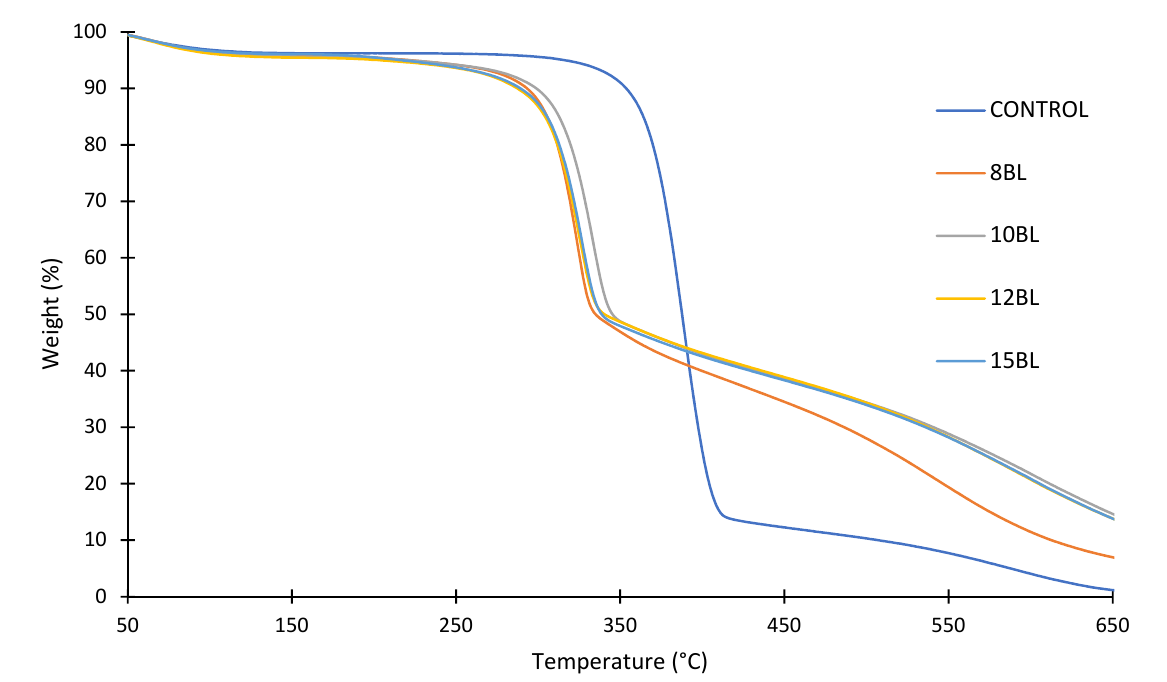
Figure 4. TGA of untreated and treated cotton fabrics with 8, 10, 12 and 15 BLs of PA/CH-U [92]. In 2020, Liu et al. studied the reduction in the flammability of cotton by using fully environmentally benign compounds—egg white protein and PA. Egg white protein is rich in amino acids, phosphorus, sulfur and metal complexes, such as calcium, iron, etc. Due to its complex nature, the protein attracts negatively charged PA. The study showed that even one BL of egg white protein and PA (70 wt%) gave excellent FR performance. TGA in air demonstrated a char yield of almost 33% at 600 °C and microscale combustion calo- rimeter (MCC) data revealed a 23% reduction in pHRR and a 67% reduction in THR [105]. Another high charge density cationic nitrogen-rich polymer used in LbL polyelectro- lyte pairs is polydiallyldimethylammonium chloride (PDAC), widely used for coagulat- ing and removing negatively charged particles and dissolved organic matter from drink- ing water [106]. Carosio et al. used a 1 wt% cationic solution of PDAC, 1 wt% anionic poly (acrylic acid) (PAA) and anionic 1 wt% suspension of APP. Cotton treated with a combi- nation of PDAC/PAA/PDAC/APP in 1, 5 and 10 quadlayers (QLs), passed the horizontal flame test (HFT) [107]. In their second study, instead of APP, they used nitrogen and phos- phorus-rich anionic 1 wt% DNA, forming 5 and 10 BLs. Such treated cotton was then im- mersed into 0.1 wt% and 1 wt% hydrotalcite (HT) nanoparticle suspensions. HT is a zeo- lite that is used as an antacid in medicine. The 0.1 wt% HT concentration lowered the minimum number of BLs required for obtaining cotton self-extinguishment. All samples passed the HFT, but the 0.1 wt% HT concentration showed the best performance in terms of pHRR (33%) and THR reductions (27%), relative to untreated cotton [108]. Jang et al. used 0.25 wt% cationic polyvinyl alcohol (PVA) and a 0.1 wt% anionic suspension of gra- phene nanoplatelets (GNP) and poly (4-styrenesulfonic acid) (PSS) to build 10 BLs on cot- ton. It resulted in a reduction in pHRR by 34.4% and in THR by 47.4%, respectively, but did not pass VFTs [95].